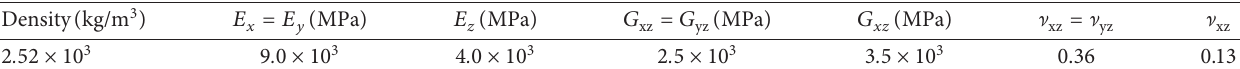
Table 2: Material parameters of the pads.